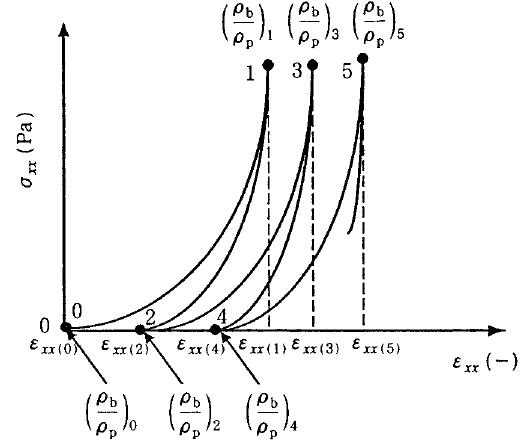
Fig. 9 . Schematics of stress-strain curve using Eqs. (6) and (7)